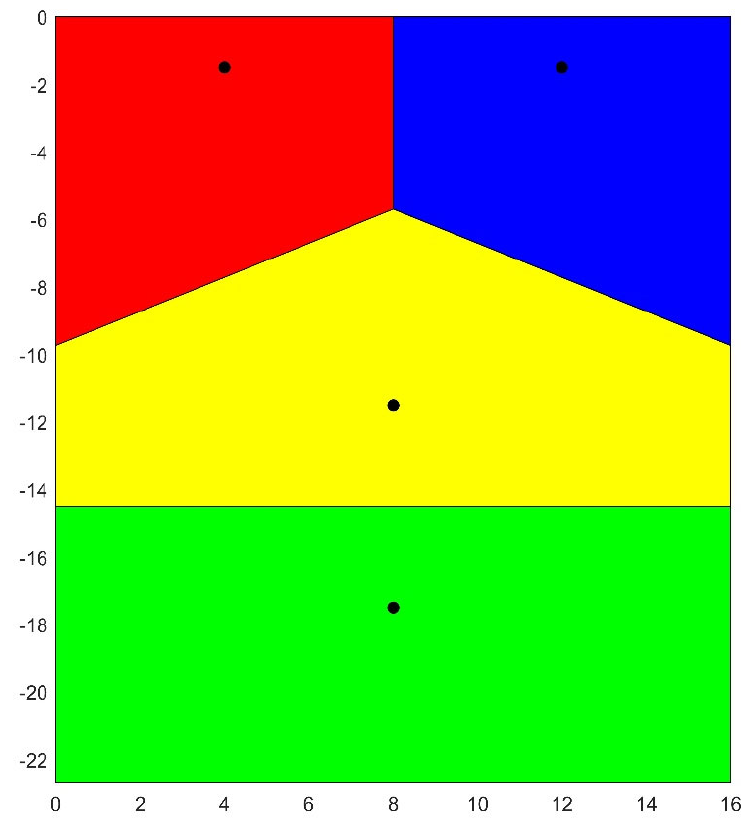
Figure 2. Voronoi Diagram with Thermocouple Locations shown as black dots.